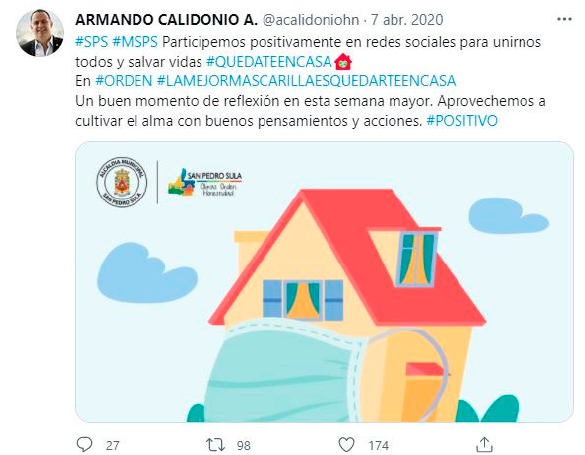
Figure 10. Example of sample content 4.